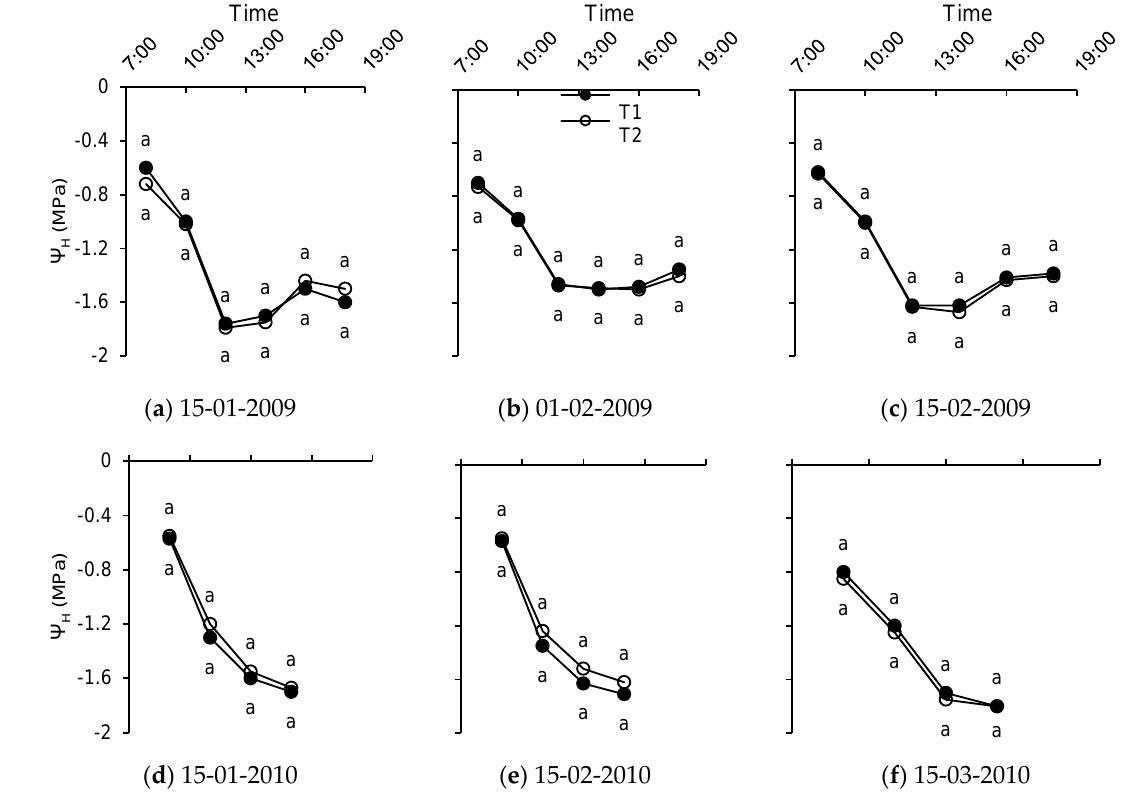
Figure 9. Hourly evolution of leaf water potential ( Ψ H ) in ‘Royal Gala’ apple trees for two water appli- cation treatments during the 2008–2009 season on: ( a ) 15–01–2009, ( b ) 01–02–2009, and ( c ) 15–02–2009, and during the 2009–2010 season on: ( d ) 15–01–2010, ( e ) 15–02–2010, and ( f ) 15–03–2010 (date: day- month-year). Each point is the average of eight repetitions. Means with the same letter for the same hour indicate that there are no significant differences according to the ANOVA test ( p < 0.05). T1: Irrigation with theoretical volume required by the plant. T2: Irrigation with farm